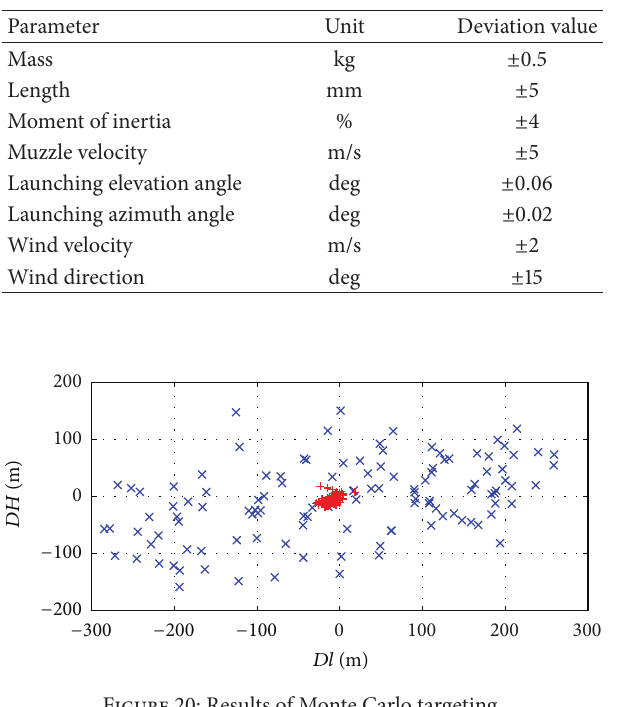
Figure 20: Results of Monte Carlo